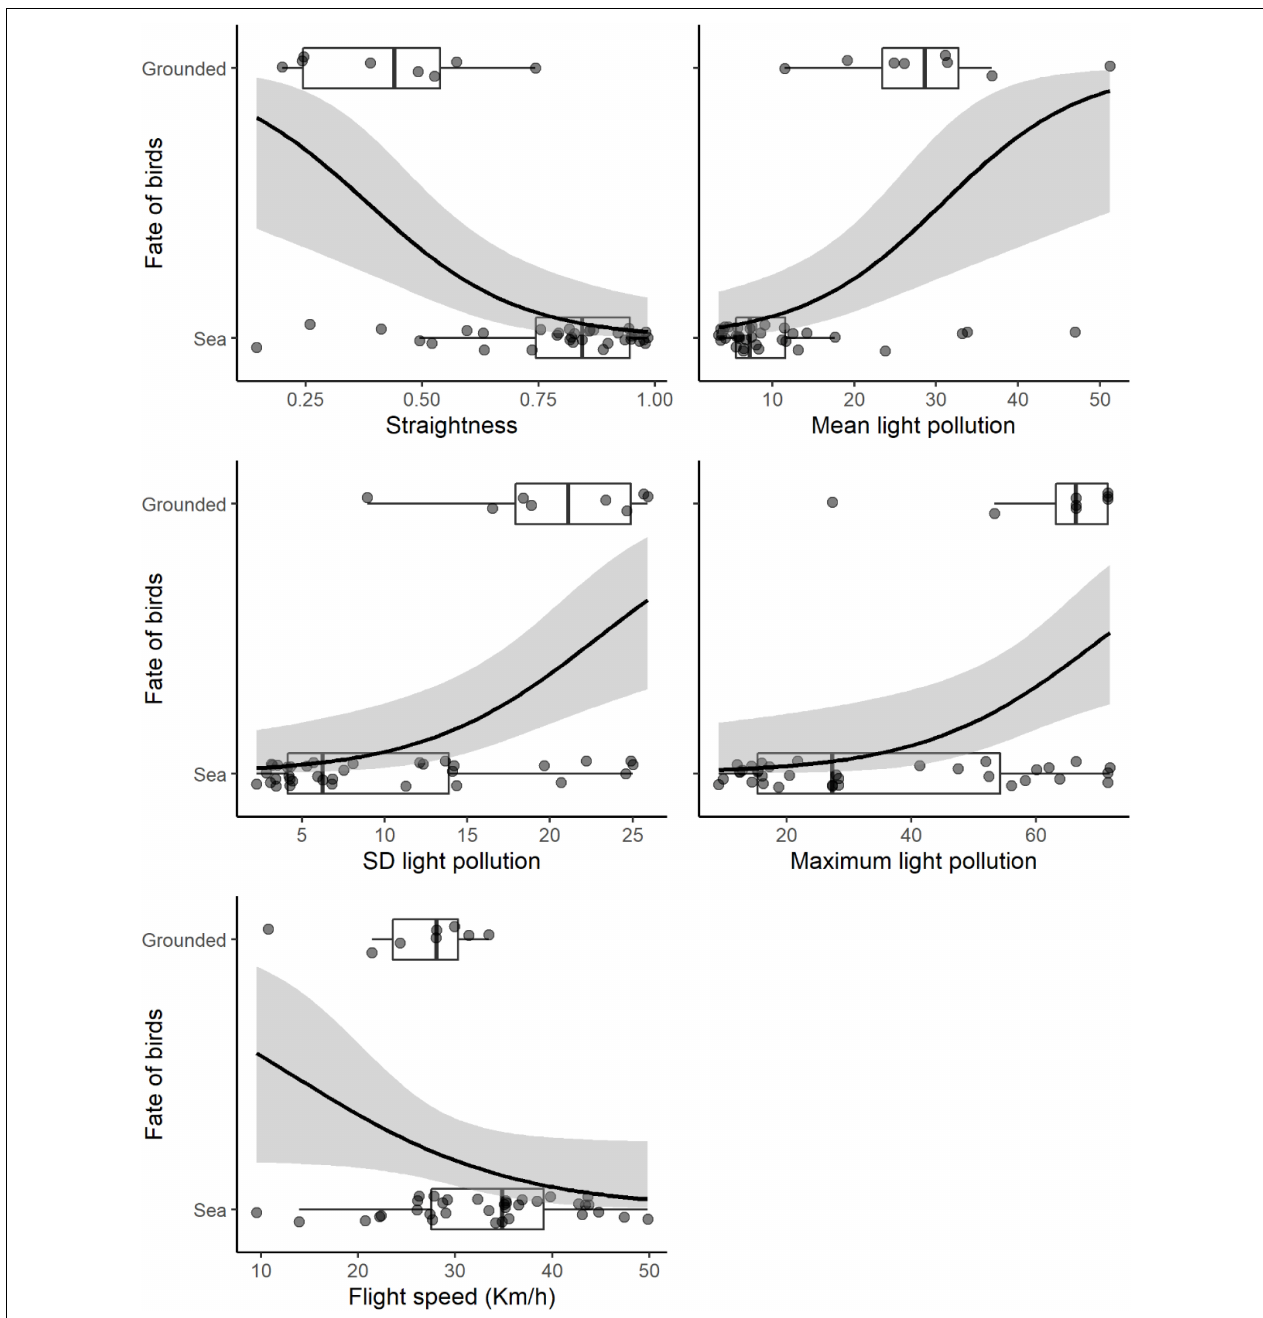
FIGURE 2 | Relation of the fate of birds (grounded birds vs. birds which reached the ocean successfully) with the significant explanatory variables (see Table 4 ). Black lines and grey areas indicate the predicted effects and the 95% confidence intervals according to the GLMs ( Table 4 ). Dots have been jittered for better visualization. The line within boxes indicated the median, the right and the left edges of the boxes represent the first and third quartiles, and the whiskers extend 1.5 times the interquartile range. Straightness is the ratio between straight distance and flight